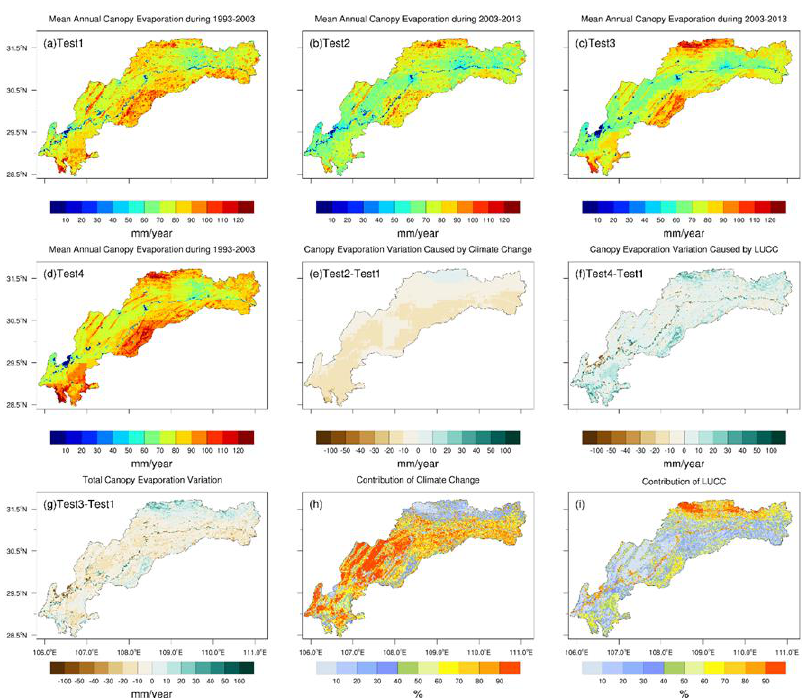
Figure 13. The spatial differences and the contribution of climate change and LUCC to canopy evaporation before and after impoundment.